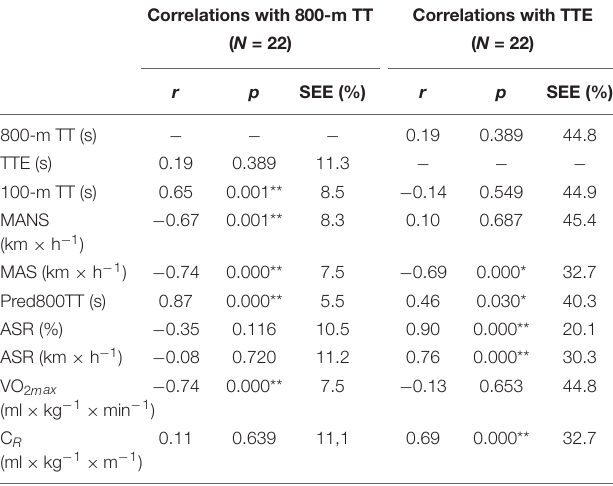
TABLE 4 | Partial correlations with 800TT and TTE, corrected for gender. With 800-m TT ( N = 22) With TTE ( N = 22)